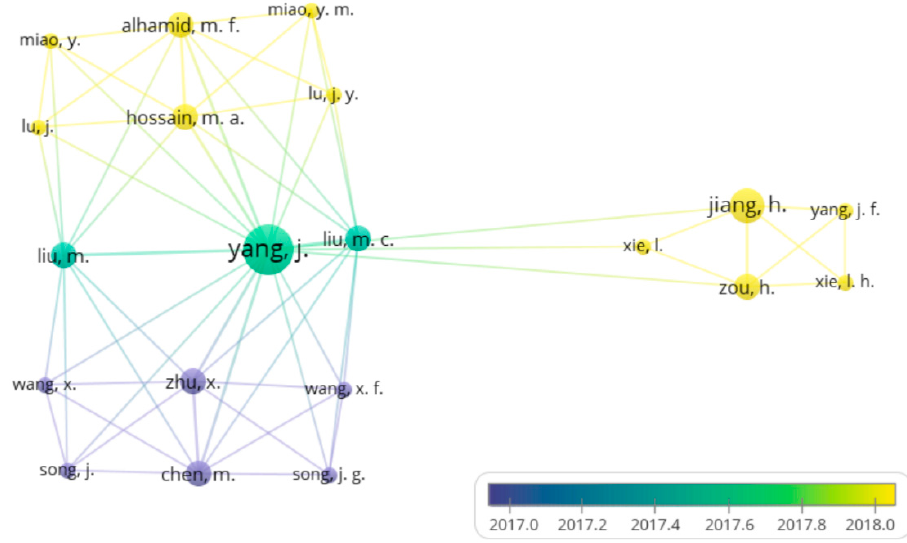
Figure 3. Network for co-authors of 20 items using full counting.